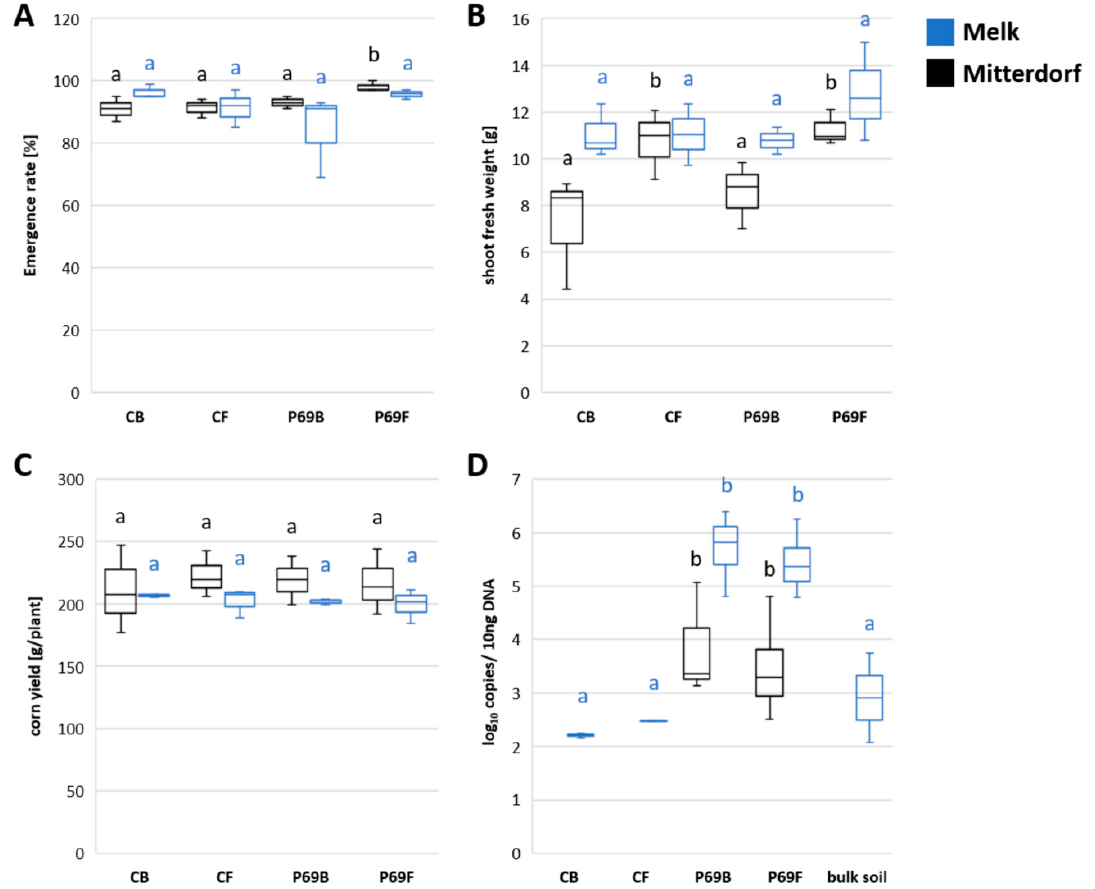
Figure 1. Plant and microbiota data (rating, qPCR). Emergence rate ( A ), shoot fresh weight ( B ), corn yield ( C ) and SPA-P69 copy numbers observed for different maize treatments ( D ). Treatments CB (control), CF (fungicide), P69B (SPA-P69) and P69F (SPA-P69 and fungicide) are labeled on the x-axis. Significance was tested using pairwise t-test within locations (indicated by letters). A detailed statistic report can be found in Table S1.